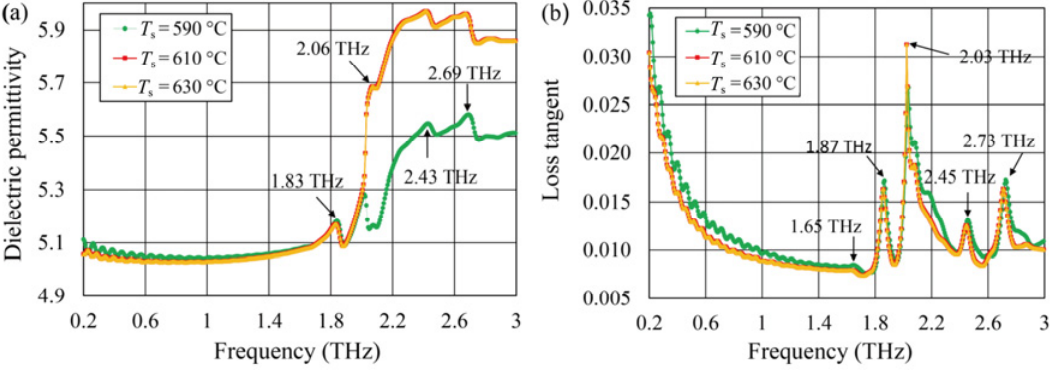
Fig. 9 Dielectric permittivity (a) and loss tangent (b) versus frequency in the range of 0.2–3 THz at 20 ℃ for Li 2 WO 4 ceramics sintered at temperatures ( T s ) of 590, 610, and 630 ℃ .